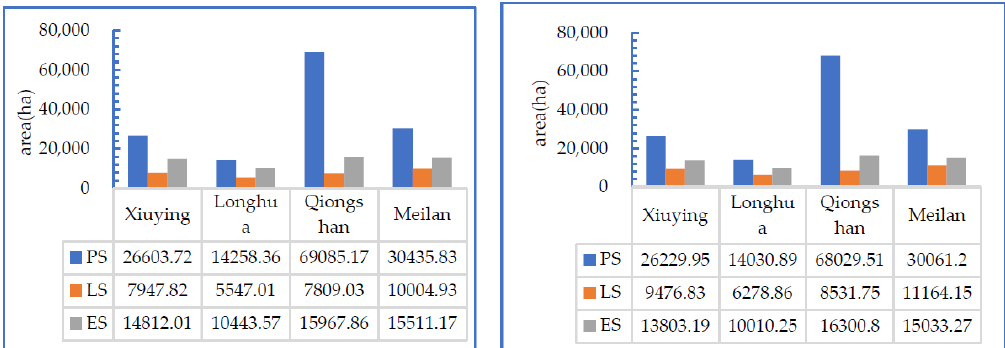
Figure 3. The scale of PLES in four Districts of Haikou, China, in 2009 and 2018.